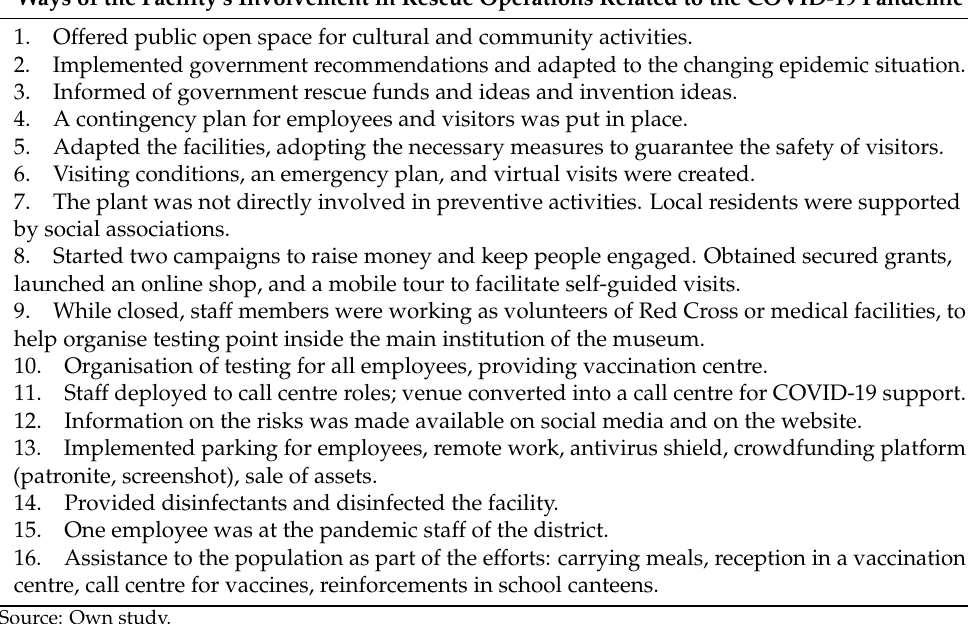
Table 3. Selected ways of involving sites in preventive